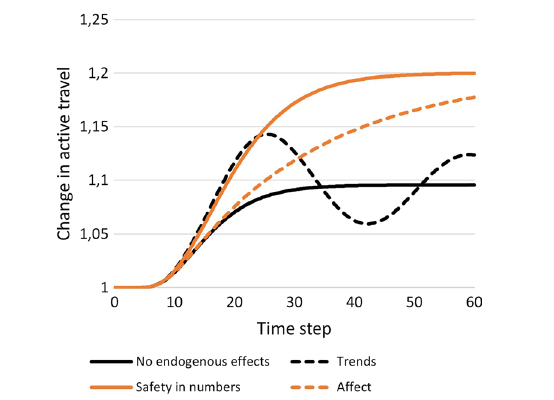
Fig. 3 Effects of an exogenous intervention under alternative feedback